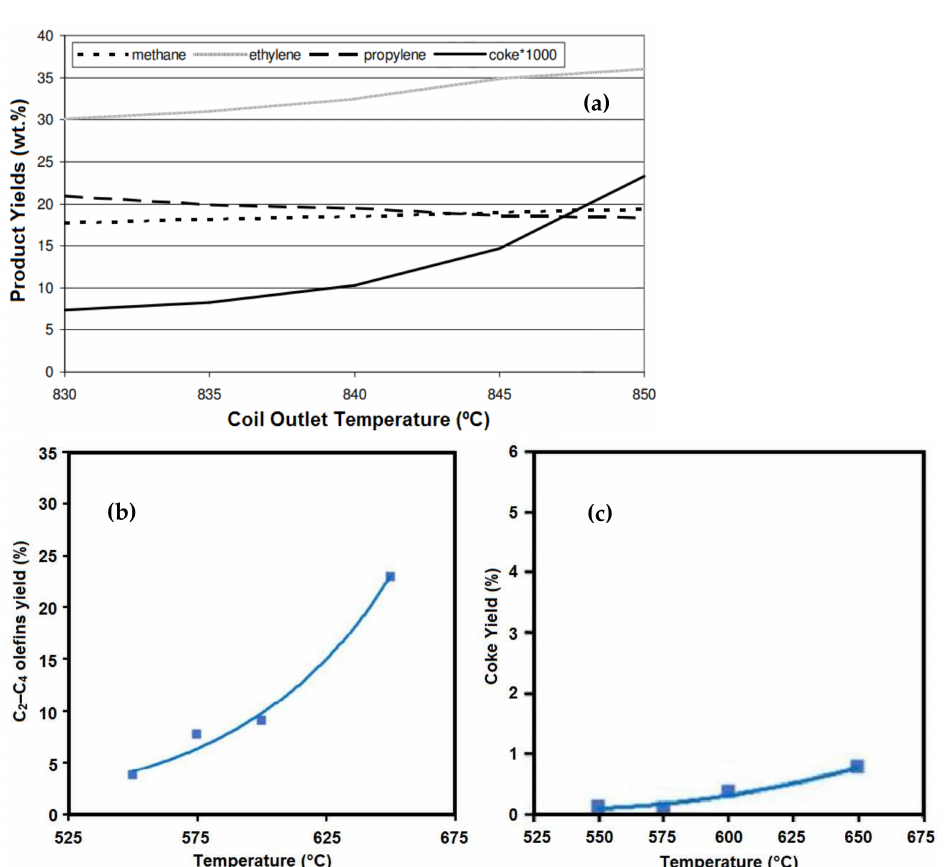
Figure 9. ( a ) Effect of coil outlet temperature on the product yields [44]; ( b ) effect of temperature on light olefin yield; and ( c ) coke formation for the cracking of Arabian Light crude oil using thermal cracking